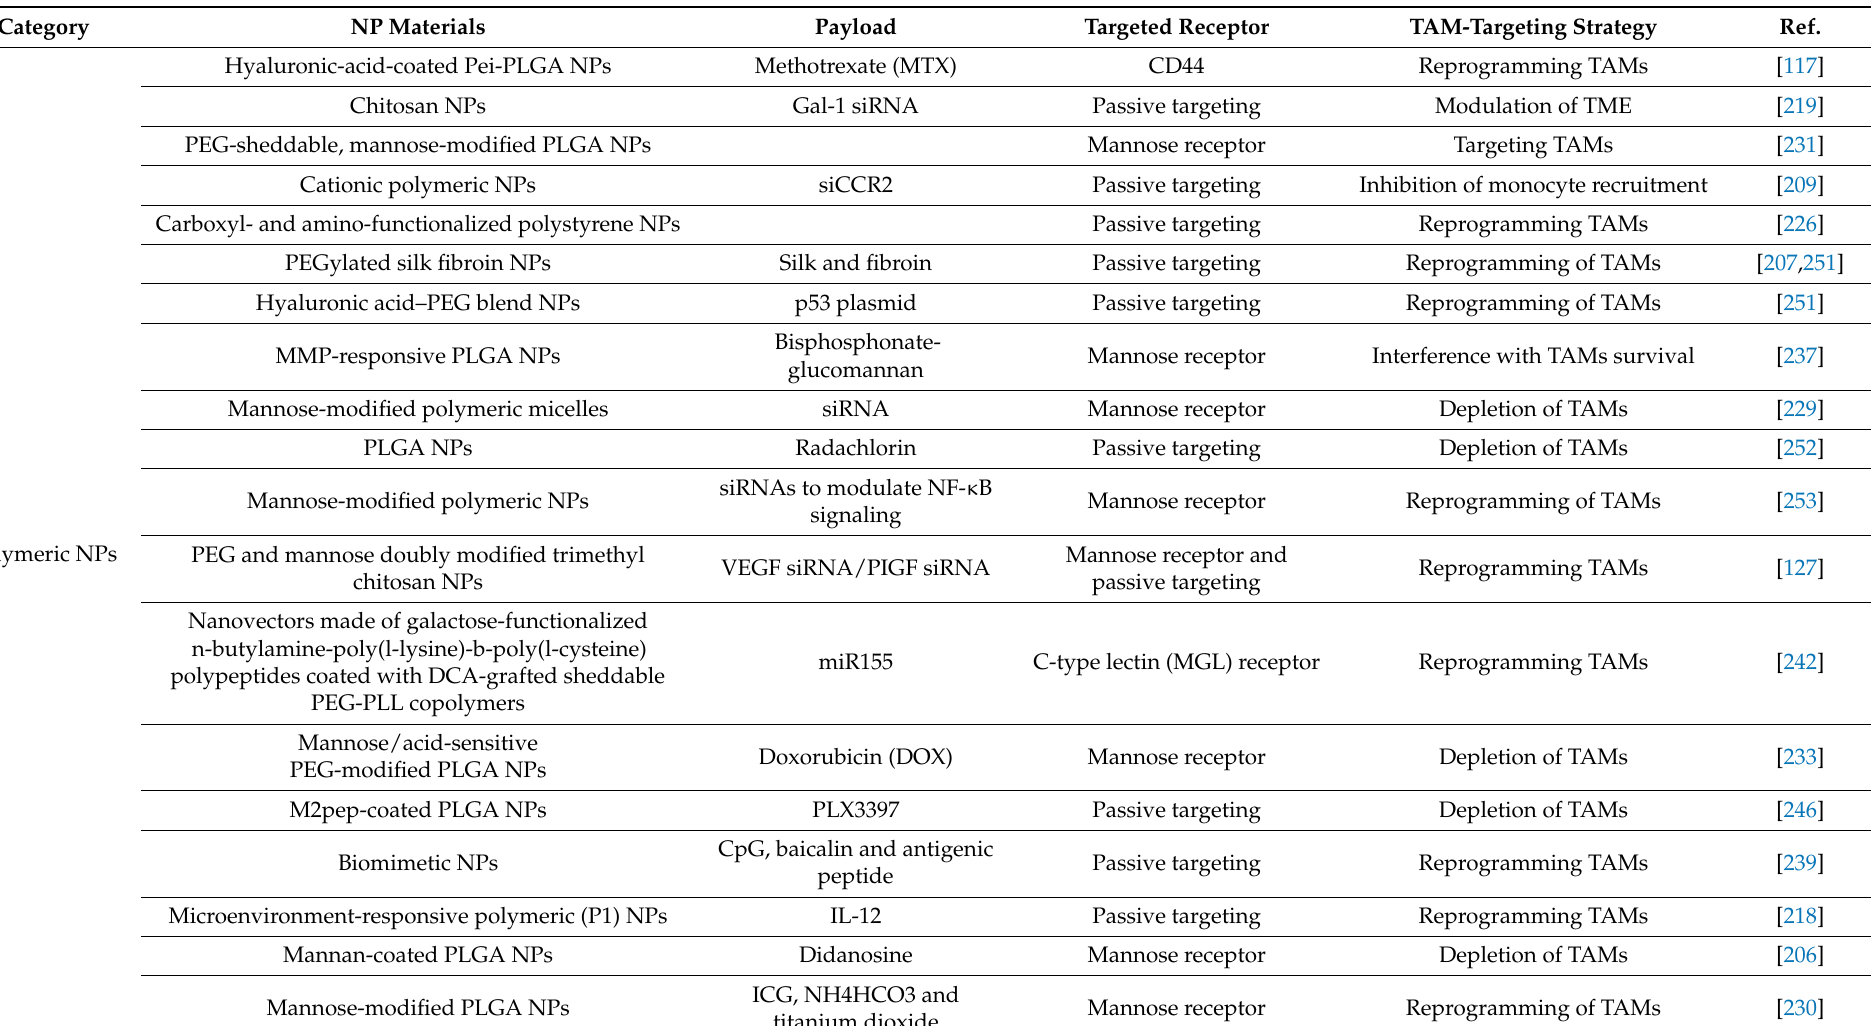
Table 2. Overview of NP-based TAM-targeting strategies in cancer